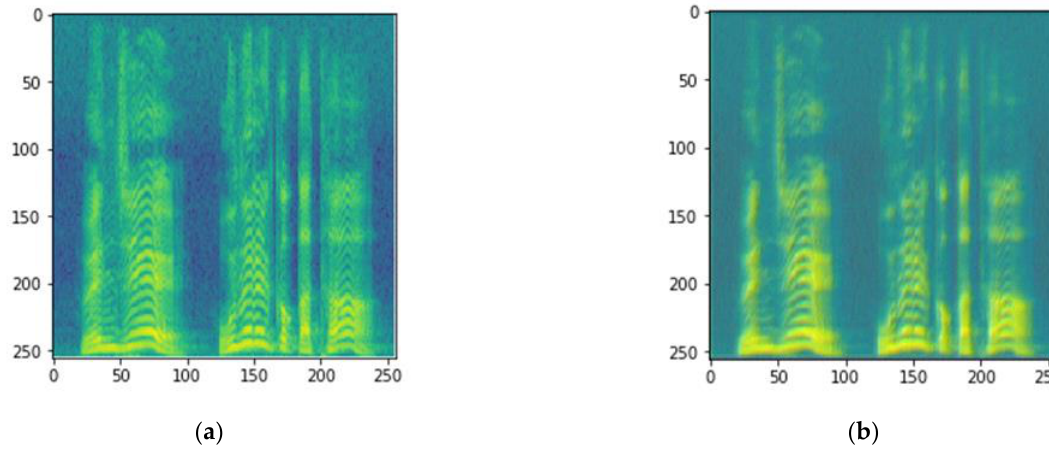
Table 1. Structure of the proposed cascaded DnCNN–CNN.